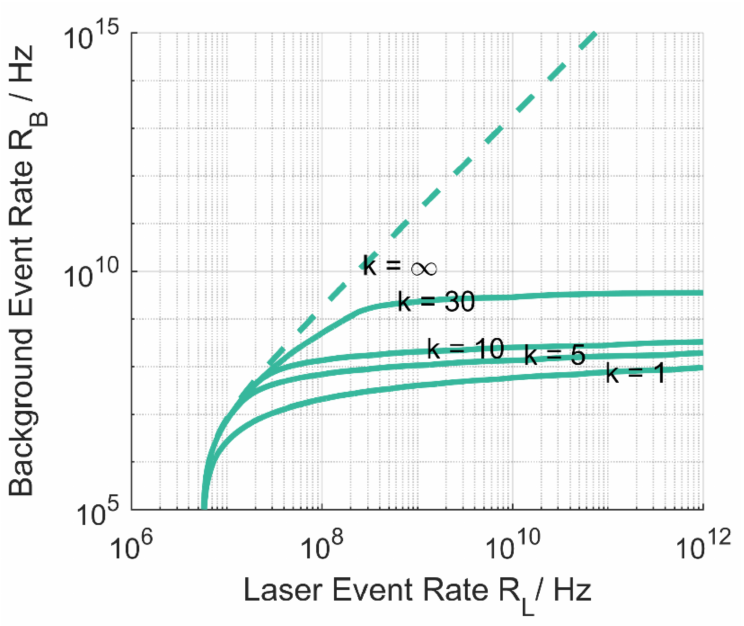
Figure 4. Behavior of the SPAD detector for higher multi-event levels k and limiting case of the linear detector. N Ph is set to 30 following from dead time and system range. SNR = 3 contour drawn for η PDE = 0.2, multi-event levels k and the linear detector (dashed line). Line for k = 1 is equivalent to Figure